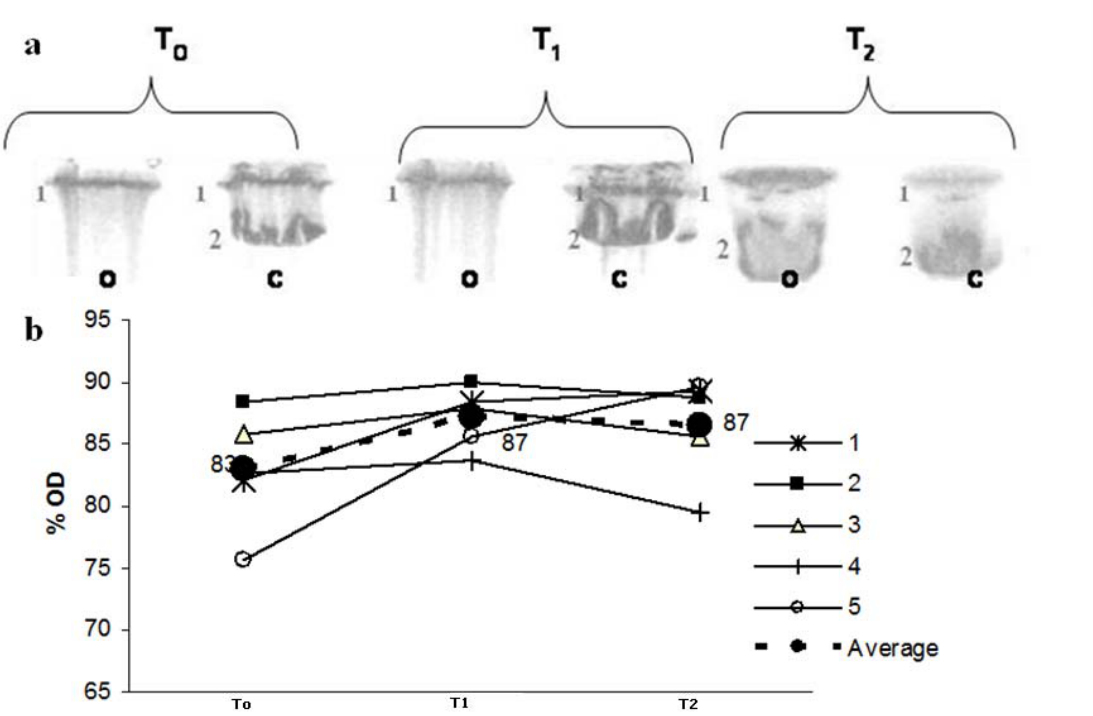
Figure 2. (a) LDL SDS-PAGE profile before C and after peroxidation O with 10 mmol/L Cu ++ at three different times: before maté tea ingestion (T ); after 1h maté tea 0 ingestion (T ) and after 1 week maté tea ingestion (T ). Lane 2 represents native LDL Apo 1 2 B (500KDa ApoB). (b) Optical density % variation during the experiment related to Lane 2 (o) in PAGE. Lines (1-5) correspond to Lane 2 OD % from each volunteer (dotted line correspond to the average